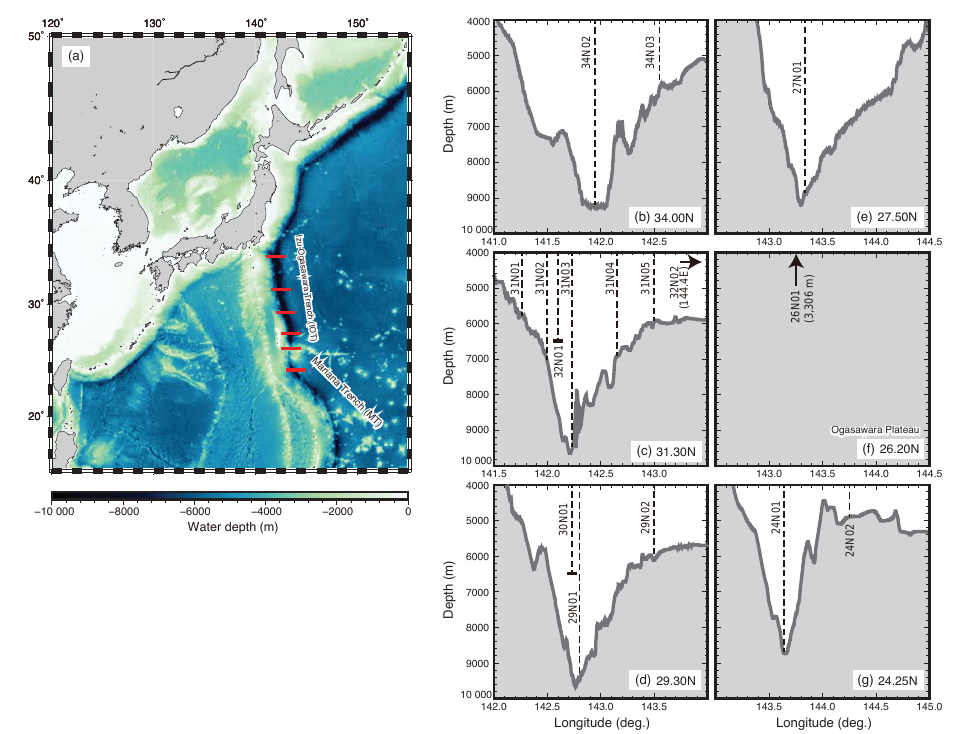
Figure 1. Seafloor topography of (a) the western North Pacific and (b–g) a cross section of the inner trench. Horizontal red lines in panel (a) represent the sections shown in panels (b–g) . Vertical dashed lines in panels (b–g) represent CTD-CMS stations (see Table 1).